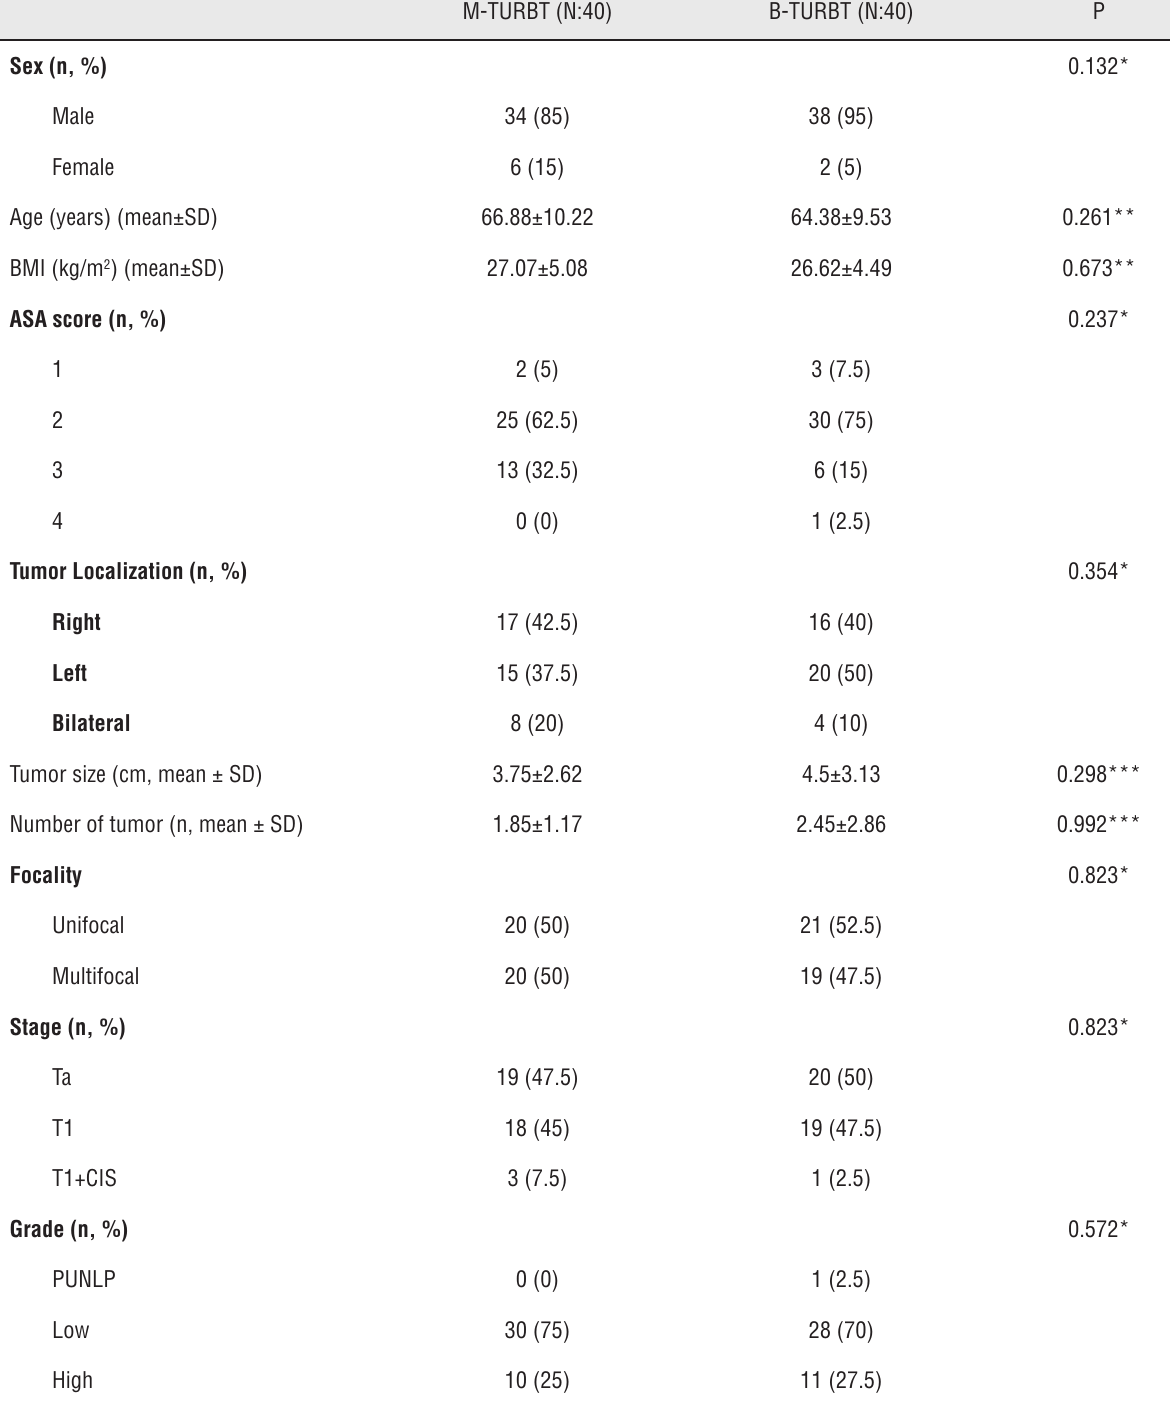
Table 1 - Demographics and tumor